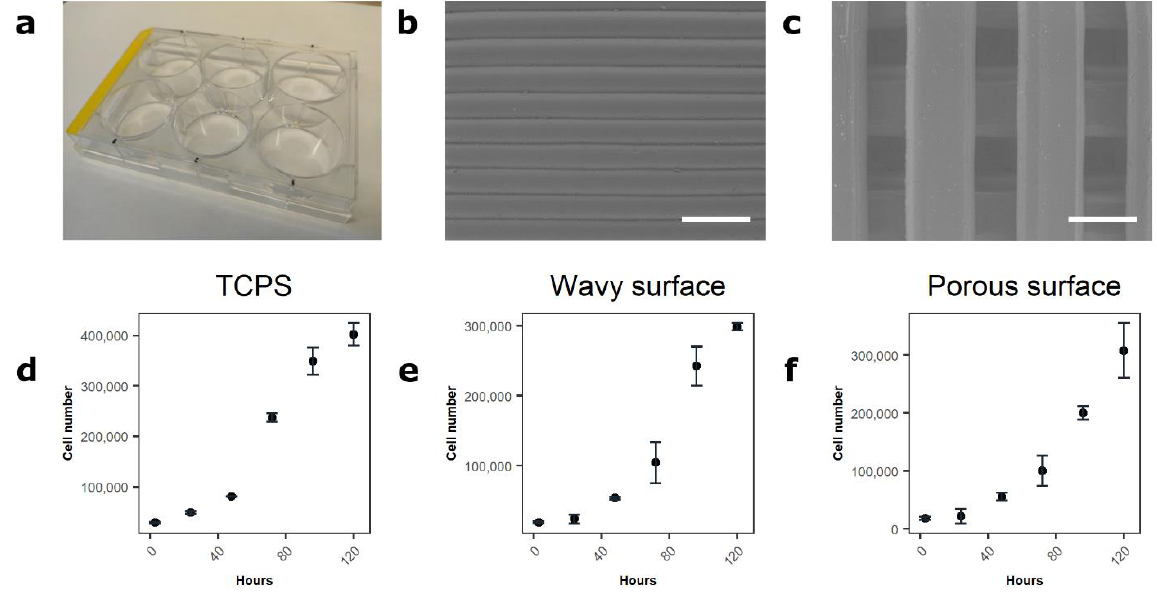
Figure 4. Assessment of cell proliferation on different surfaces. ( a – c ) tissue culture plate surface (TCPS), wavy and porous scaffolds, respectively; ( d ) DPSC proliferation on TCPS; ( e ) DPSC proliferation on 2.5D wavy surface; ( f ) DPSC proliferation on 3D porous scaffolds. Scale bars in ( b , c ) represent 500 µ m. Values in graphs are shown as mean ± SD. Five samples were used for each time